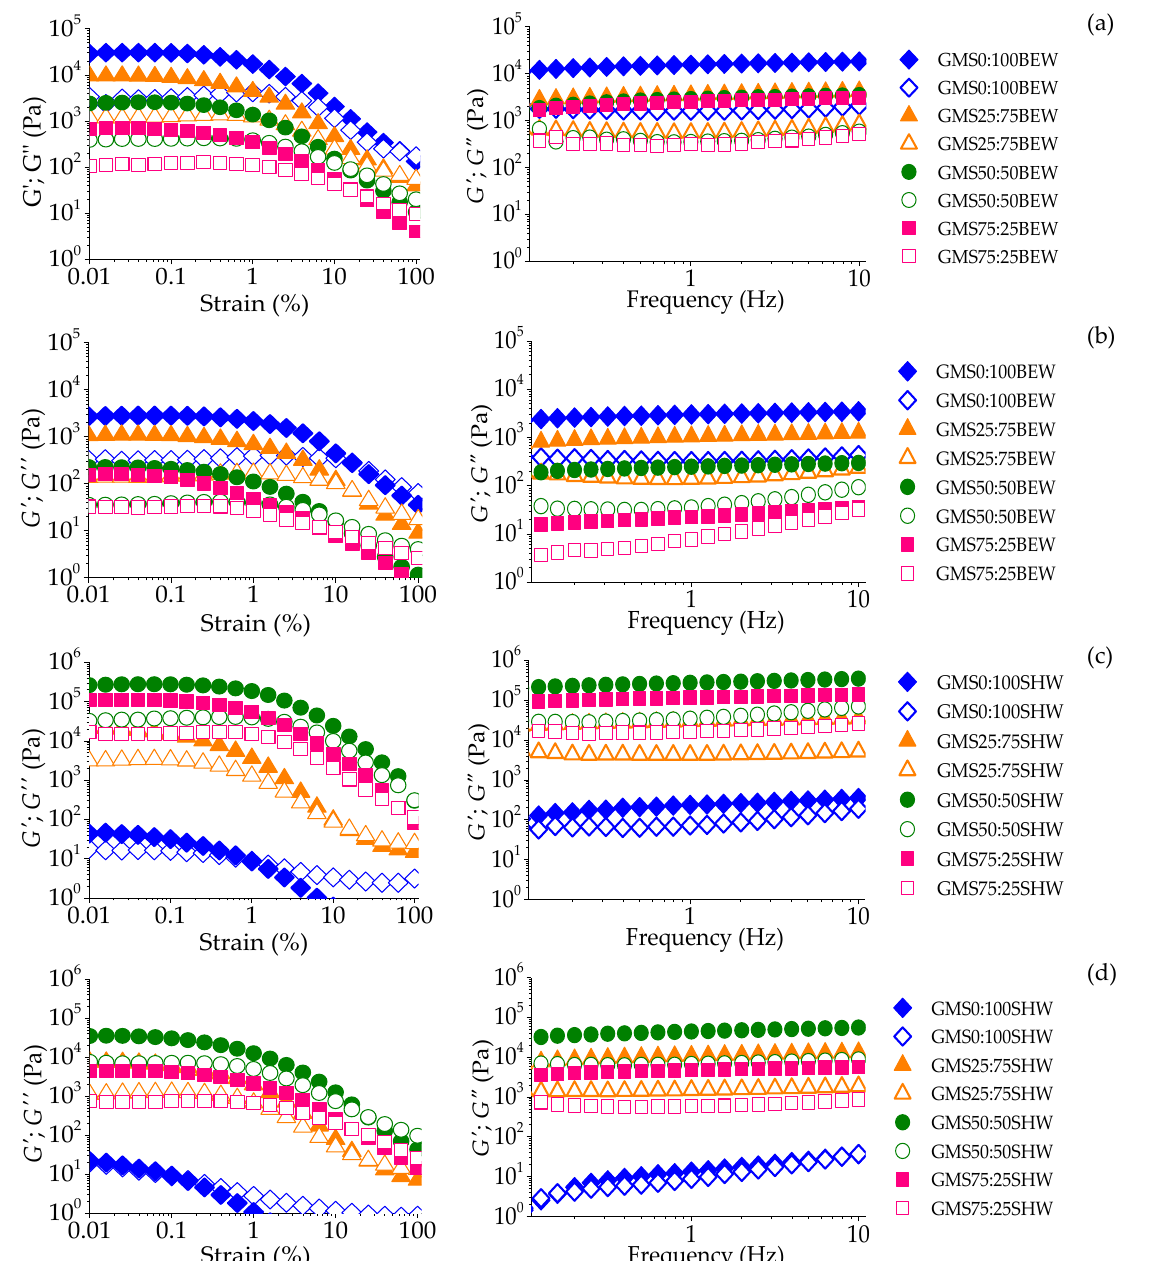
Figure 1. Strain (left) and frequency sweeps (right) for GMS:BEW-based oleogels at 5 °C ( a ), GMS:BEW-based oleogels at 25 °C ( b ), GMS:SHW-based oleogels at 5 °C ( c ), and GMS:SHW-based oleogels at 25 °C ( d ).